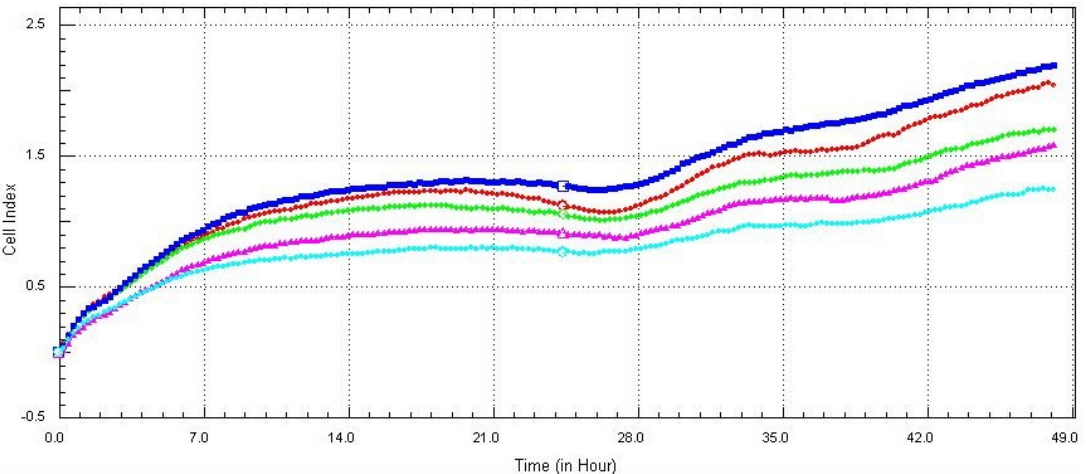
Figure 3. Real–time analysis of (RTCA) screening of PAECs. Cells were seeded at 0 h and GPs were administrated at 24 h. Cell growth was then monitored for the following 24 h. Deep blue (5 µ g/mL), deep red (10 µ g/mL), green (20 µ g/mL), purple (50 µ g/mL), turquoise (100 µ g/mL).